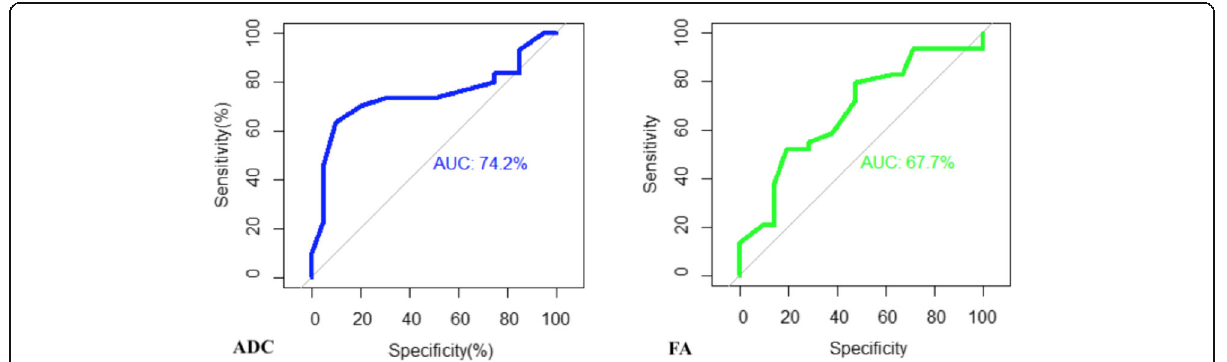
Fig. 8 ROC curve of DWI “ ADC ” (to the left) and DIT “ FA ” (to the right) to predict breast malignant tumor